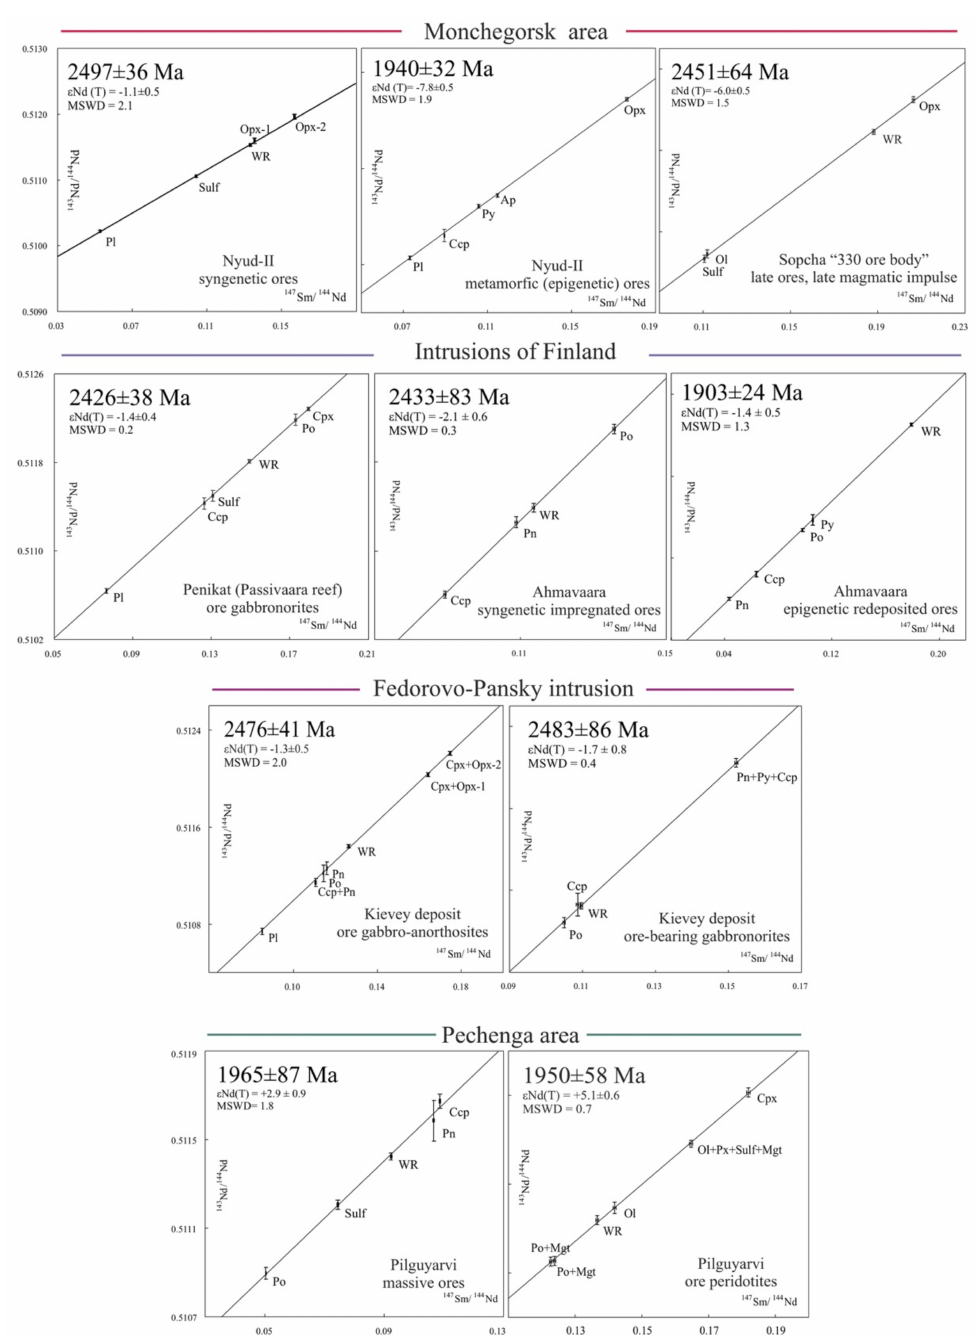
Figure 2. Mineral Sm-Nd isochrones for the main Cu-Ni-PGE ore deposits in the northeastern part of the Fennoscandian Shield. Data from [1–5]. ε Nd (T)—isotopic composition of